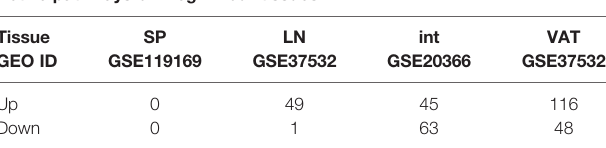
TABLE 6 | Ingenuity Pathway Analysis (IPA) also showed that the expression changes of upregulated, and downregulated genes of Treg vs. Tconv from different tiers of four tissues were involved in canonical pathways to maintain their roles of